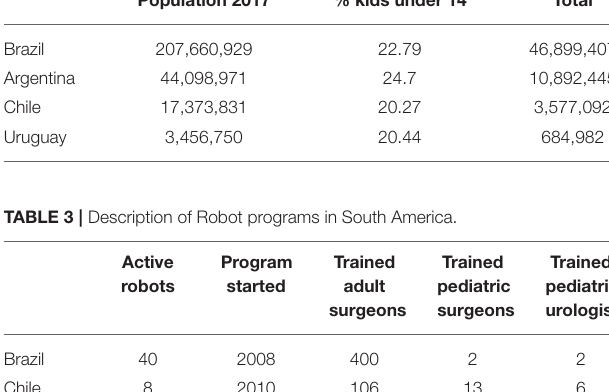
TABLE 1 | Number of Robots related to the country population. Country/region